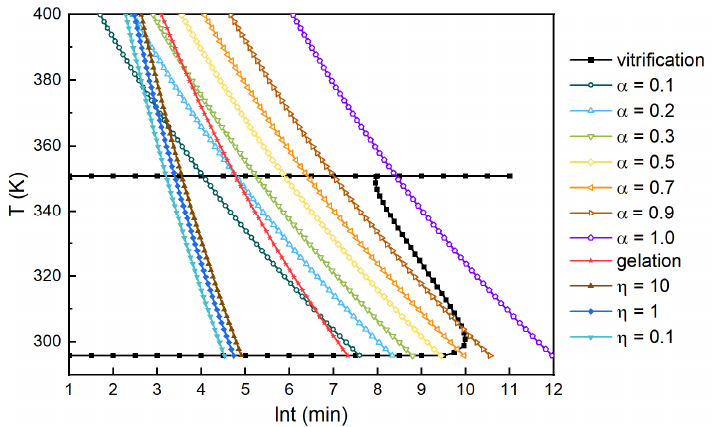
Figure 22. TTT– η diagram of the H 6 XDI/BES system. Figure 22. TTT- η diagram of the H